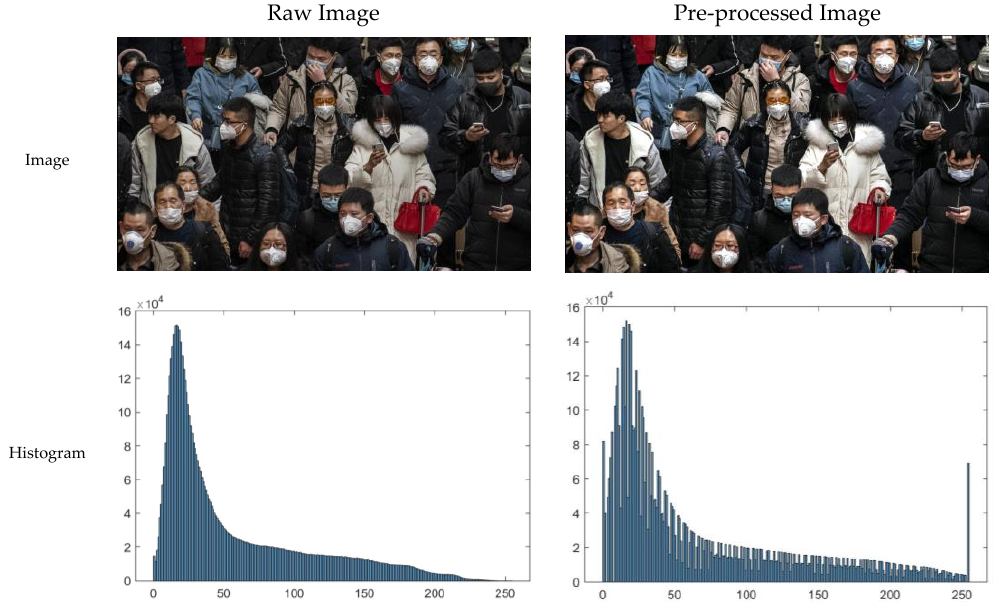
Figure 2. Diagram image pre-processing and corresponding histogram. The illumination and contrast of the image are higher through the image pre-processing process, where more details are visible. The original image was from the Medical Masks Dataset (https://www.kaggle.com/vtech6/medical- masks-dataset).